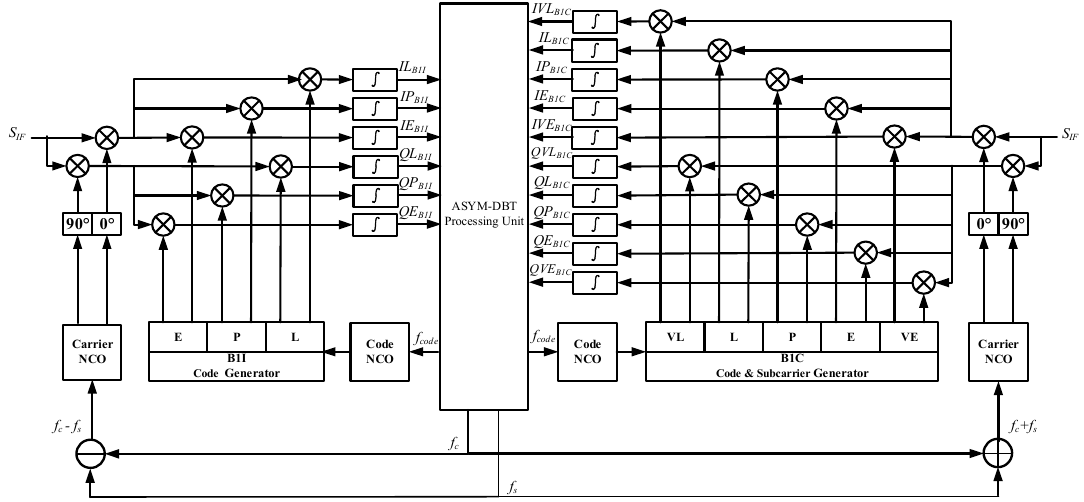
Figure 4. The tracking channel architecture of ASYM-DBT for the B1-ADS signal.